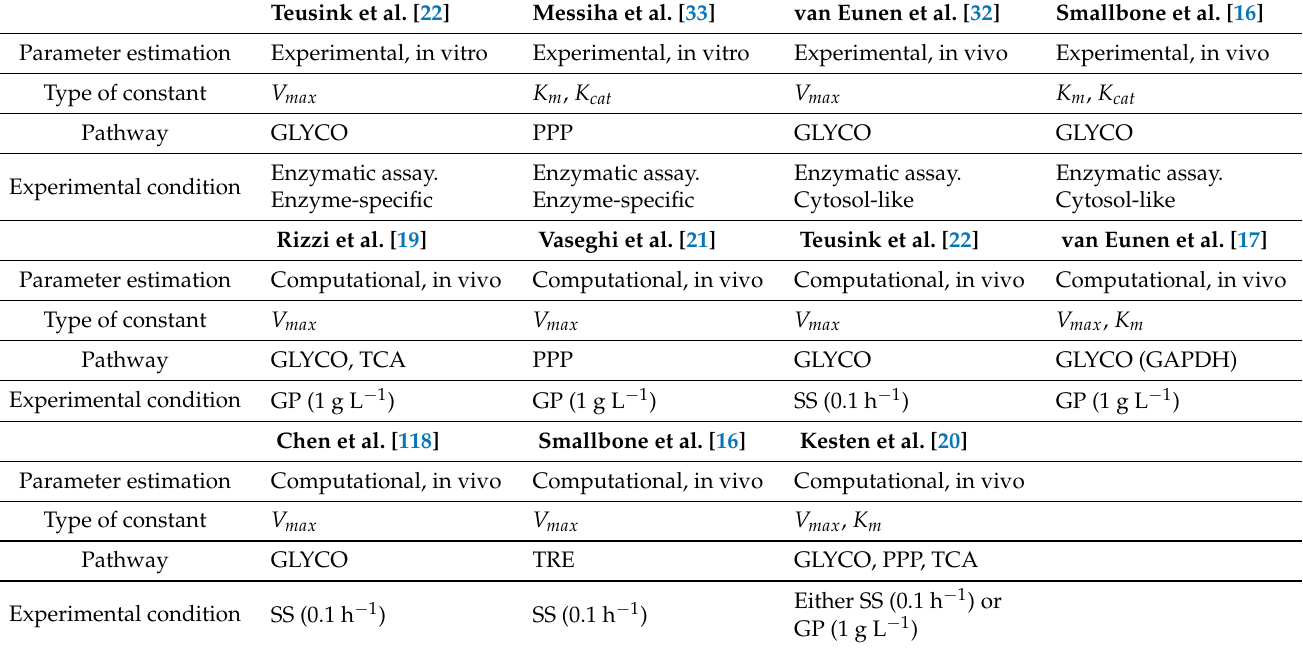
Table 3. Overview of studies that quantify central metabolism kinetic constants in S. cerevisiae : Only works that aimed to study glycolysis as a system are shown. Prior works that studied glycolytic oscillations or individual enzymes are not displayed. Experimental data that did or did not resemble the yeast cell cytosol are referred to as in vivo or in vitro, respectively. Pathways parameterized are glycolysis (GLYCO), tricarboxylic acid cycle (TCA), pentose phosphate pathway (PPP), trehalose cycle (TRE). From the literature pool of articles obtained in the systematic reviewing process, the works displayed estimated parameter values. Publications [16,22] appear in two columns because they simultaneously used two different parameter estimation methods to quantify the same and different kinetic constants type, respectively. Literature is ordered by parameter estimation